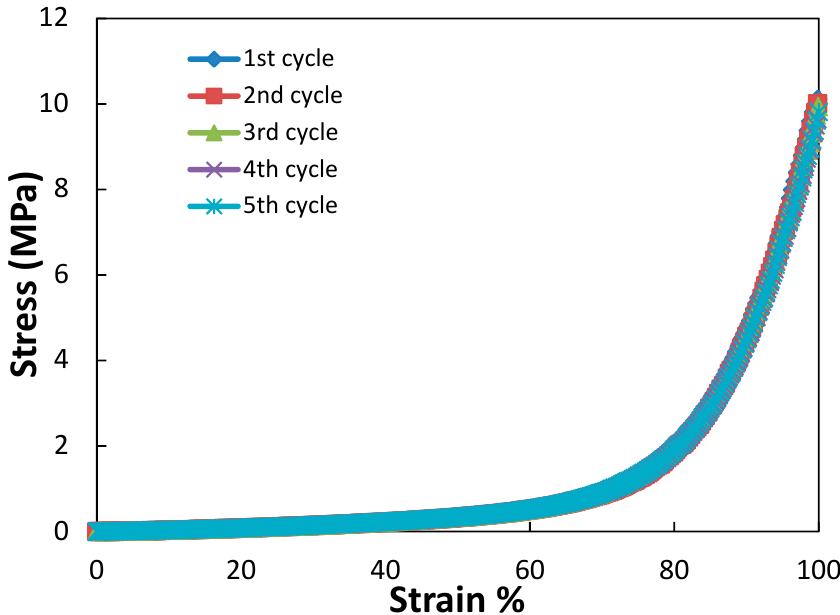
Figure 6. Repeated loading of a partially hydrolyzed PAA/PNVF hydrogel. After five high strain compression cycles there was negligible change in the stress–strain curves of the hydrogel, indicating the hydrogel did not undergo any irreversible damage due to repeated loading cycles.